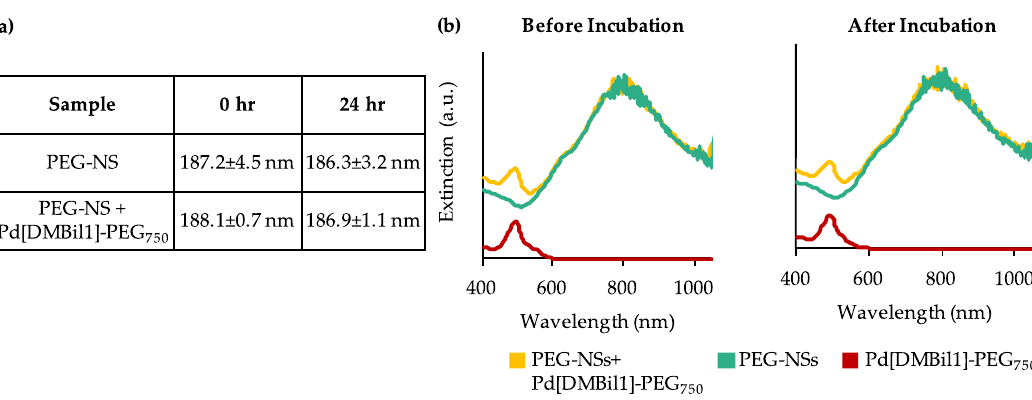
Figure 2. ( a ) Hydrodynamic diameter (z-average) and ( b ) Extinction spectra of PEG-NSs and/or Pd[DMBil1]-PEG 750 in cell culture medium before ( left ) and after ( right ) a 24 h incubation period.